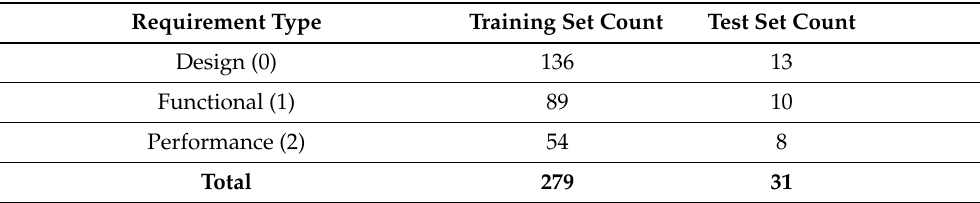
Table 8. Breakdown of the types of requirements in the training and tests